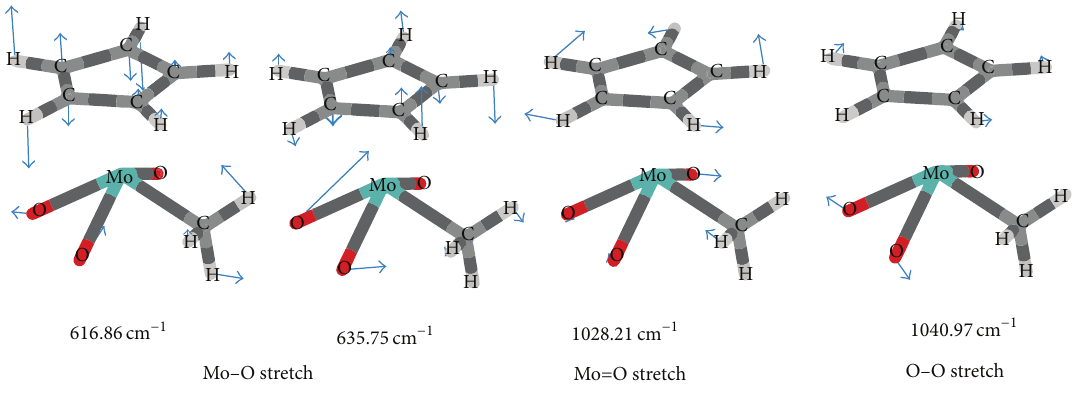
Figure 2: Normal modes associated with MoO( 𝜂 2 -O 2 ) of 1-C2 .